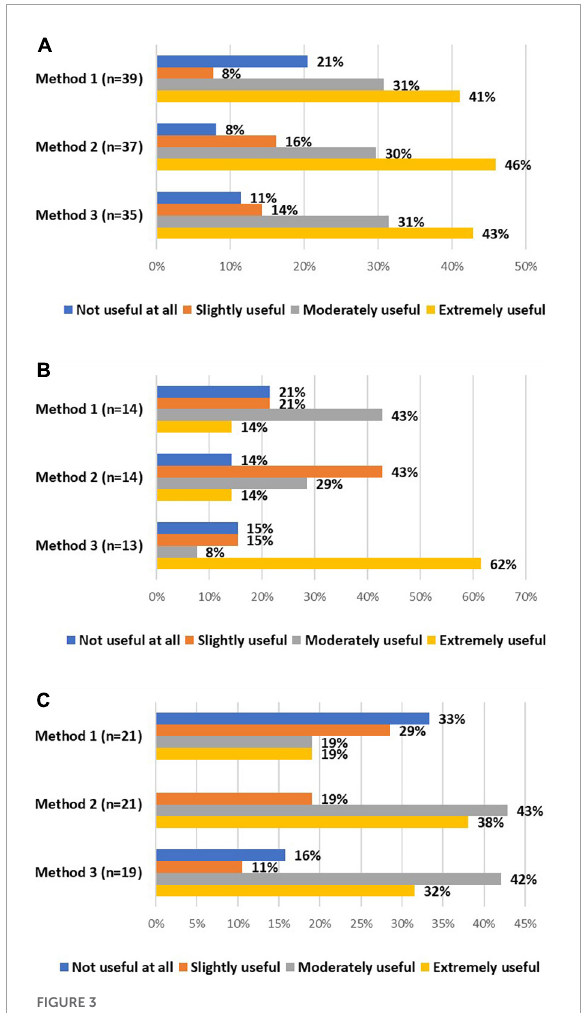
FIGURE3 The views of investigators (A) , DPOs/legal experts (B) , and EC members (C) on the usefulness of method 1 (i.e., obtaining oral consent supplemented with email confirmation), method 2 (i.e., obtaining oral consent, followed by an appropriately signed and dated IC), and method 3 (i.e., using validated electronic systems) to re-consent for already included research